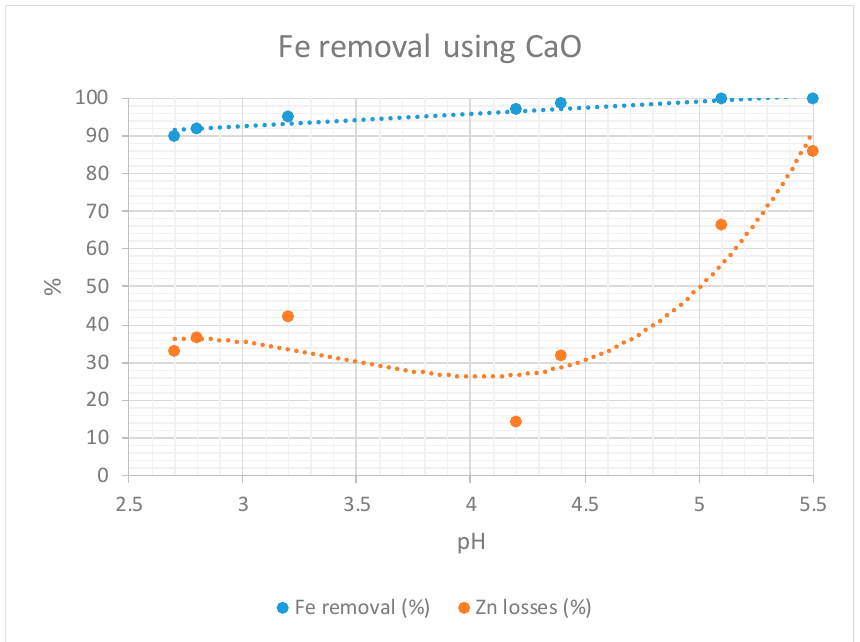
Figure 5. Exploratory test results using CaO.